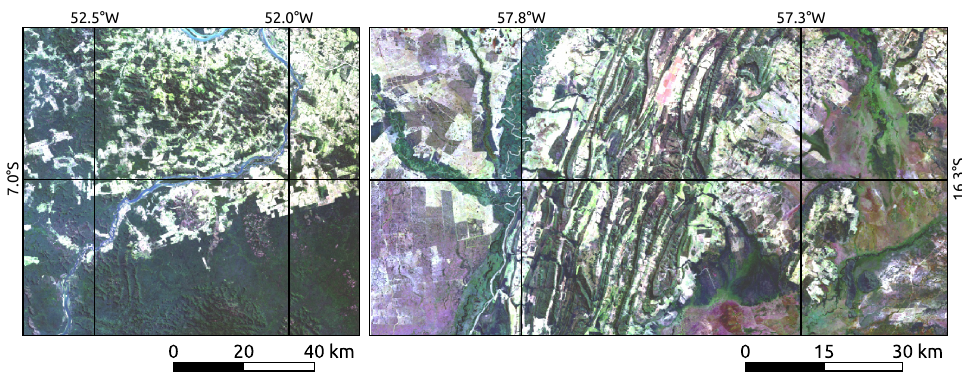
Figure 3. Location of the study areas.